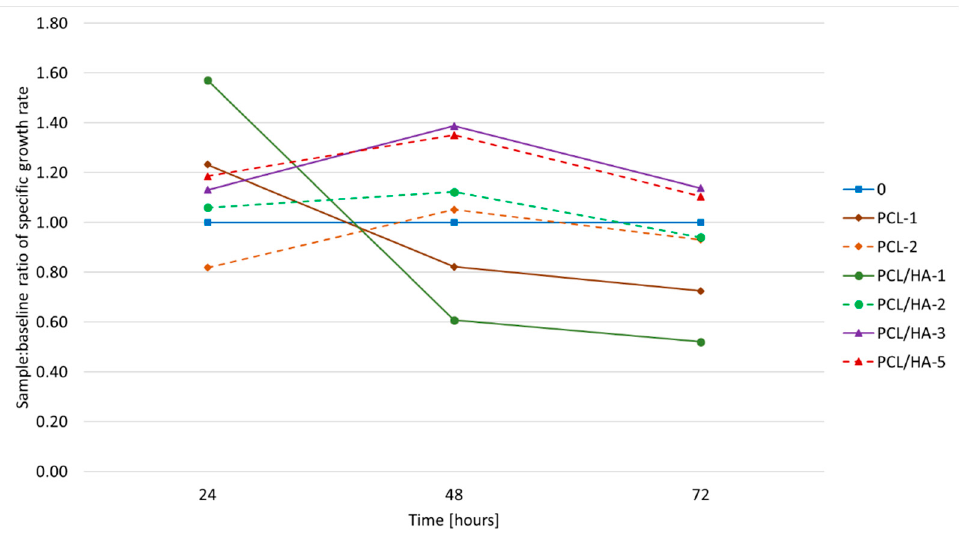
Figure 9. Specific growth rate ratio of the samples and the control.